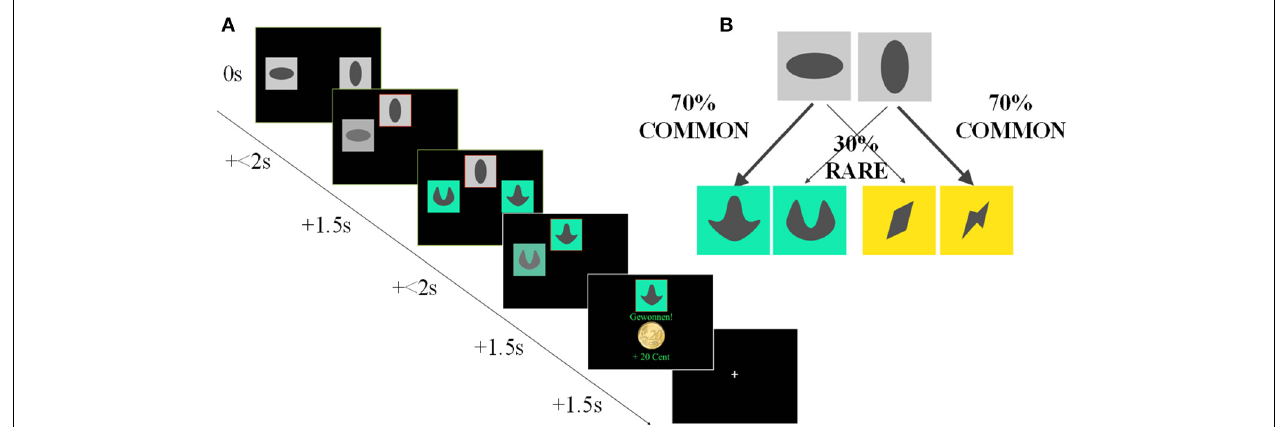
FIGURE 2 | Sequential Decision-Making Task (Two-Step), according to Daw et al. (2011). (A) Trial configuration for the Experiment. Each trial consisted of two different stages, and each stage involved a choice between two stimuli. In the first stage, subjects chose between two abstract stimuli on a gray background. The chosen stimulus was highlighted by a red frame and moved to the top of the screen, where it remained visible for 1.5s; at the same time, the other stimulus faded away. Subjects then reached a subsequent second stage. Here subjects saw one of two further pairs of colored stimuli and again chose between these. The monetary outcome